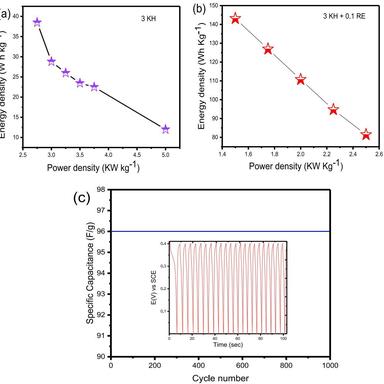
Ragone plots of LBG-cl-PAN- IONP electrodes in (a) 3 KH; (b) 3 KH+0.1RE; (c) Cyclic stability of the LBG-cl-PAN- IONP HNC electrode in 3 KH showing the capacitance retention after 1000 cycles using a charge/discharge at constant current density 20 Ag-1. The inset shows the charge− discharge curves of the LBG-cl-PAN- IONP electrode in 3 KH.